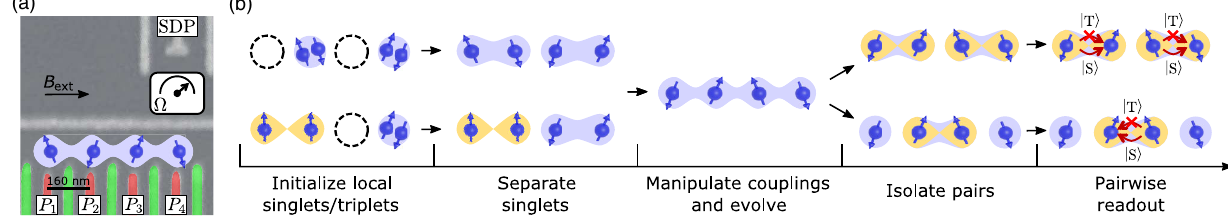
FIG. 1. Device and spin-chain operation. (a) False-colored scanning electron micrograph of a device nominally identical to the one used for the experiments. The resistance meter, indicated with Ω , shows the location of the sensing dot. Plunger gates for the dots are colored in red and labeled with P , and the plunger for the sensing dot is labeled with SDP. (b) Schematic illustration of the experimental i sequence for the spin chain, consisting of five stages: initialization of local singlets or triplets, separation of singlets, manipulation of exchange couplings and time evolution, isolation of either the left and the right pair or the middle pair by switching off specific exchange couplings, and pairwise singlet-triplet